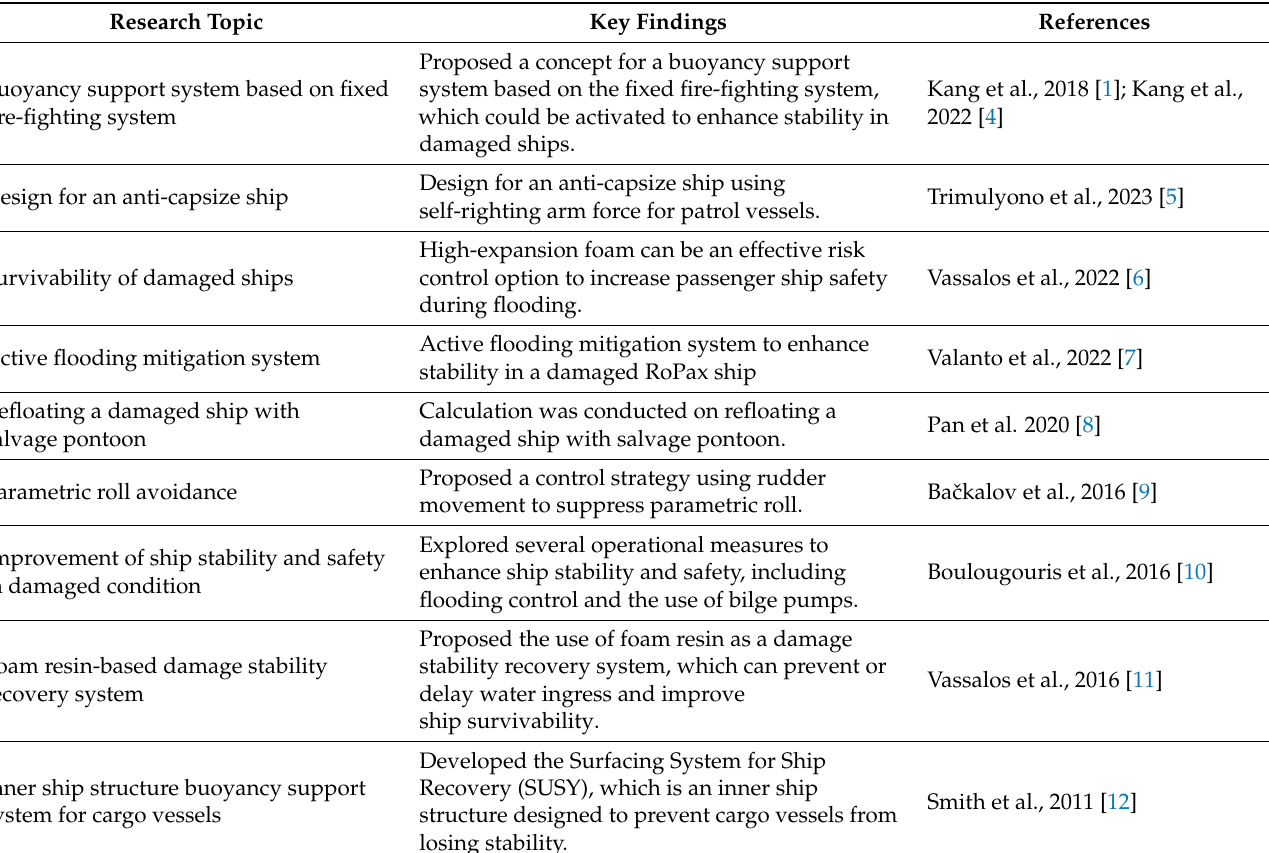
Table 1. Research for the improvement of survivability of damaged